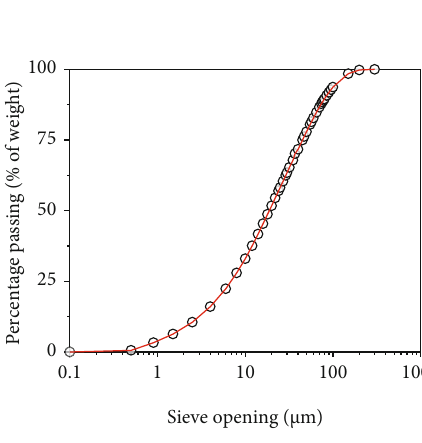
Figure 3: Gradation curve of the tailing sand. Figure 4: Geotextile picture.